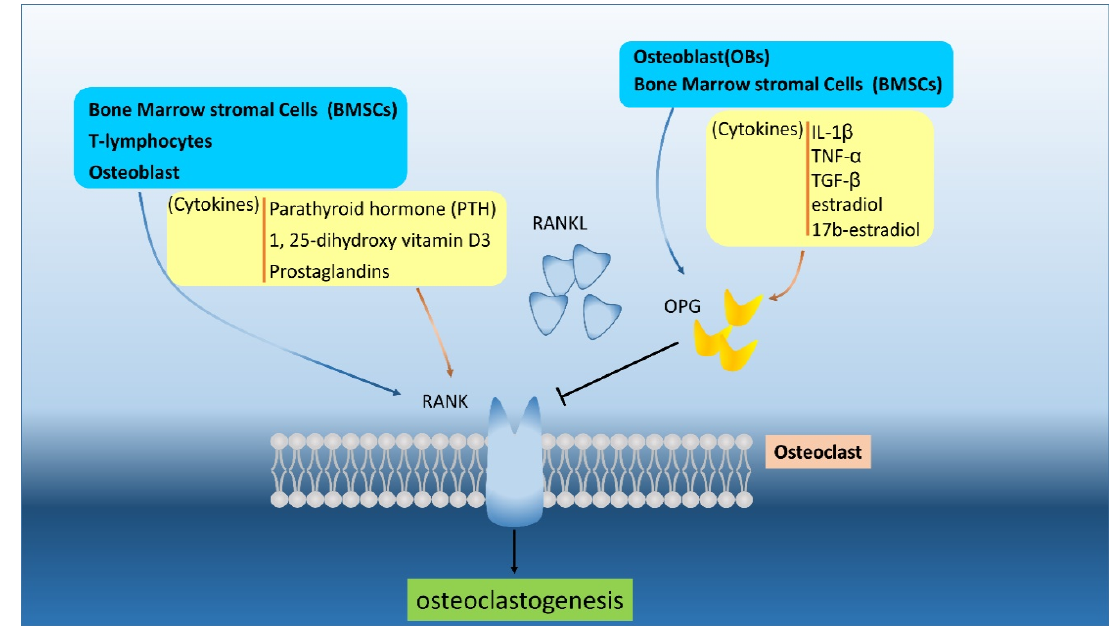
Figure 1. The RANKL/OPG/RANK (receptor activator of NF-kappa B Figure 1. The RANKL / OPG / RANK (receptor activator of NF-kappa B ligand / osteoprotegerin / ligand/osteoprotegerin/receptor activator of NF-kappa B) are secreted and regulated by various cells and different cytokines. The RANKL and OPG can be produced by bone marrow stromal cells (BMSCs) and osteoblasts (OBs) to interact or compete RNAK in osteoclast and osteoblast. The OPG can regulated by cytokines, like interleukin (IL)-1β, tumor necrosis factor (TNF)-α, TGF-β, estradiol, and 17b-estradiol.